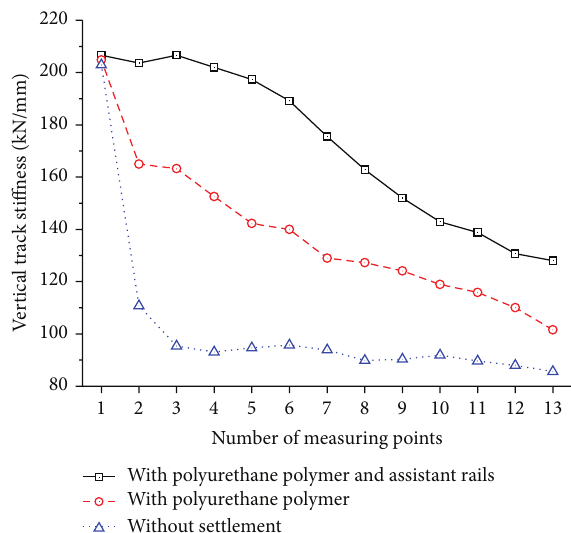
Figure 6: Vertical track stiffness of the transition section.